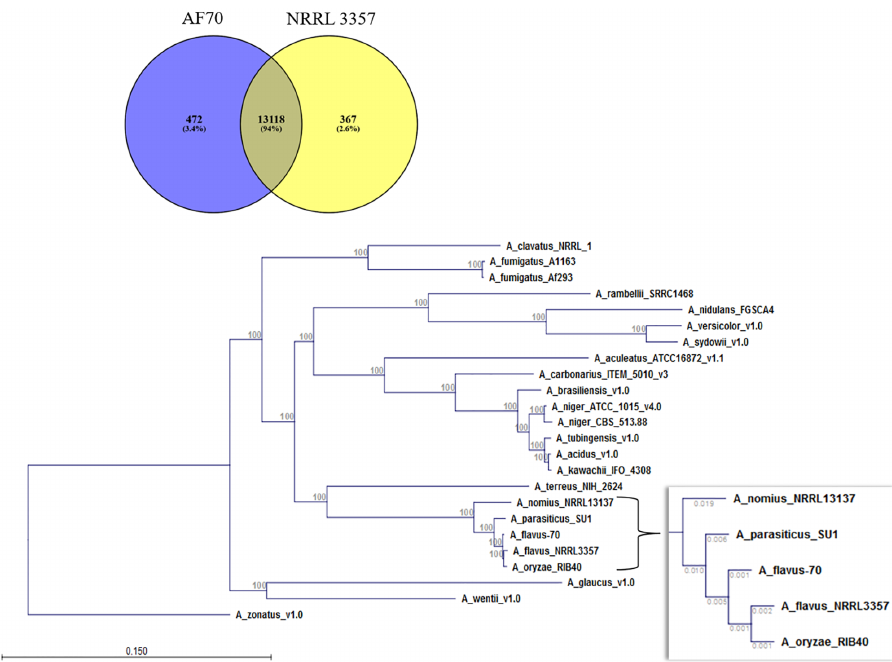
Fig 2. Genome comparisons of A . flavus strain AF70 and NRRL 3357. A) Number of genes identified as unique or shared between strains AF70 and NRRL 3357 (S and L strains, respectively) indicate 94% of genes are shared (orthologous). B) Protein sequences were compared and used to illustrate the hierarchal relationship between strains AF70, NRRL 3357 and closely related species, and indicate that NRRL 3357 (“A_flavus_NRRL3357”) is more closely related to A . oryzae (“A_oryzae_RIB40”) than A . flavus AF70 (“A_flavus 70”). Values on main tree indicate bootstrap values. Values on inset indicate branch